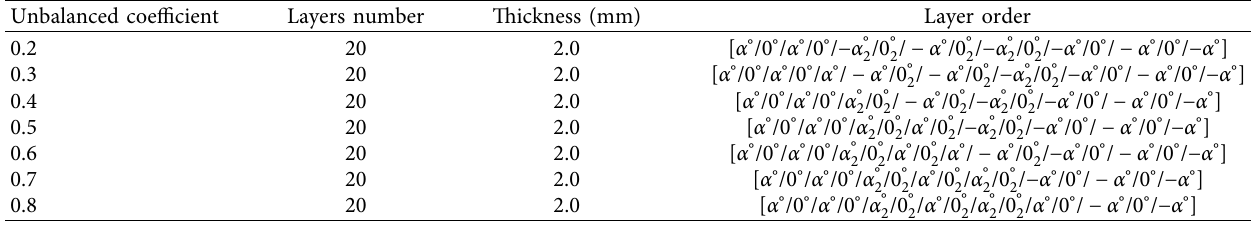
Table 3: Initial layering scheme.